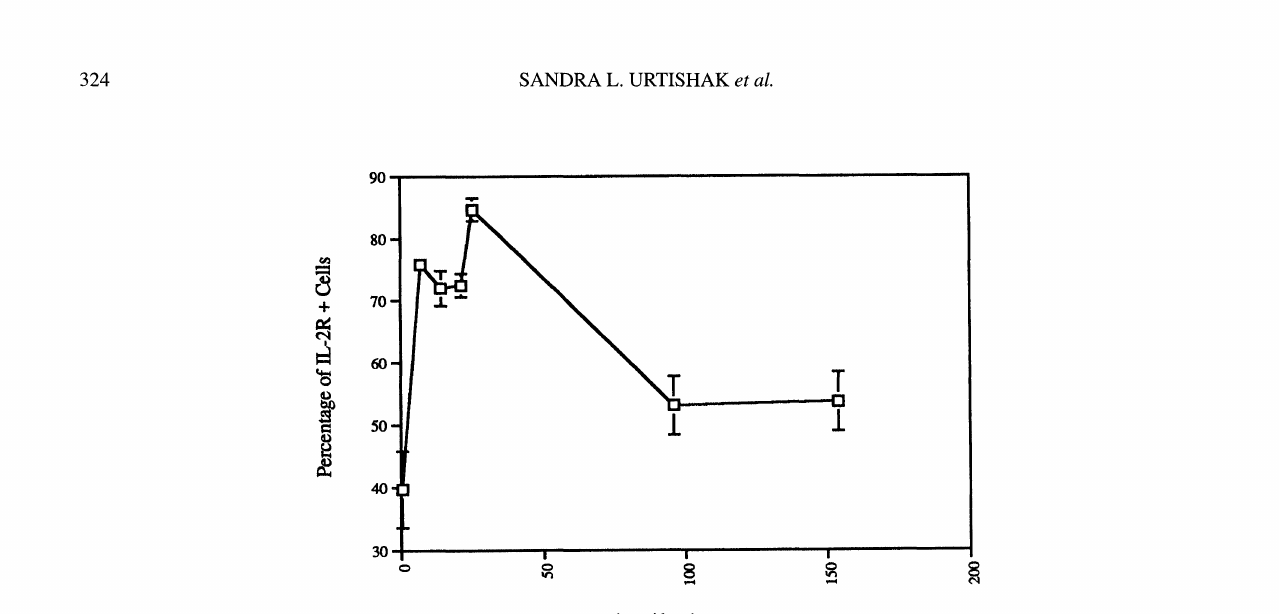
FIGURE 5 Change in IL-2R expression with age. IEL from Sprague Dawley rats were isolated and analyzed by flow cytometry after staining with a monoclonal antibody to the chain ofthe IL-2 receptor. Values are shown as percentages one standard deviation, n=2 for all ages. One way ANOVA indicated that IL-2R expression at times < 50 days varied significantly from that at > 50 days (p <